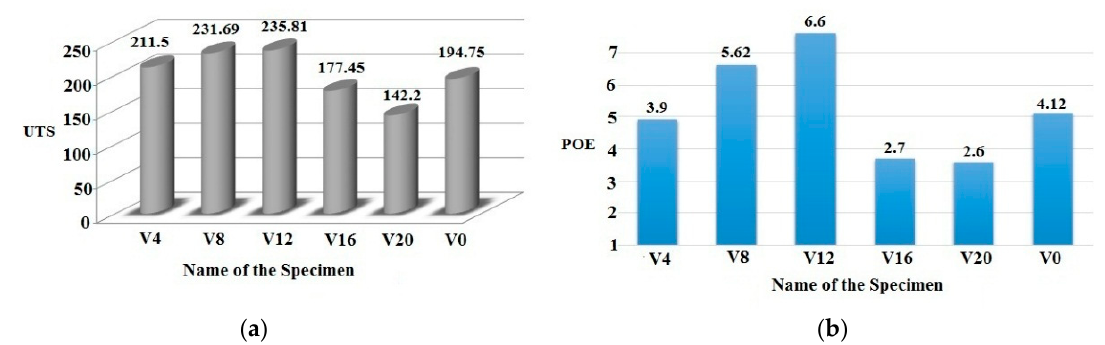
Figure 12. Comparative analysis of AZ31B/SiC nanocomposite joints on ( a ) ultimate tensile strength (UTS); ( b ) percentage of elongation (POE).